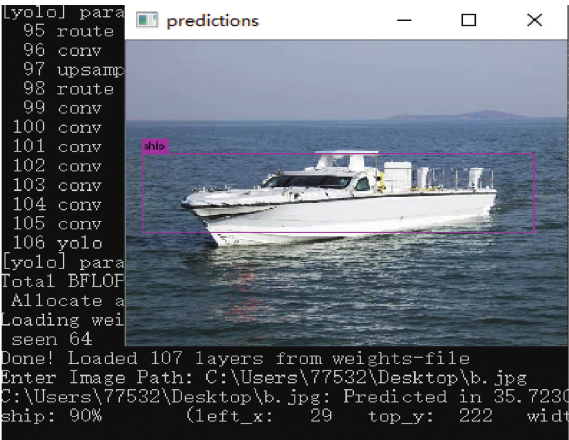
Figure 5: Ship target detection effect.